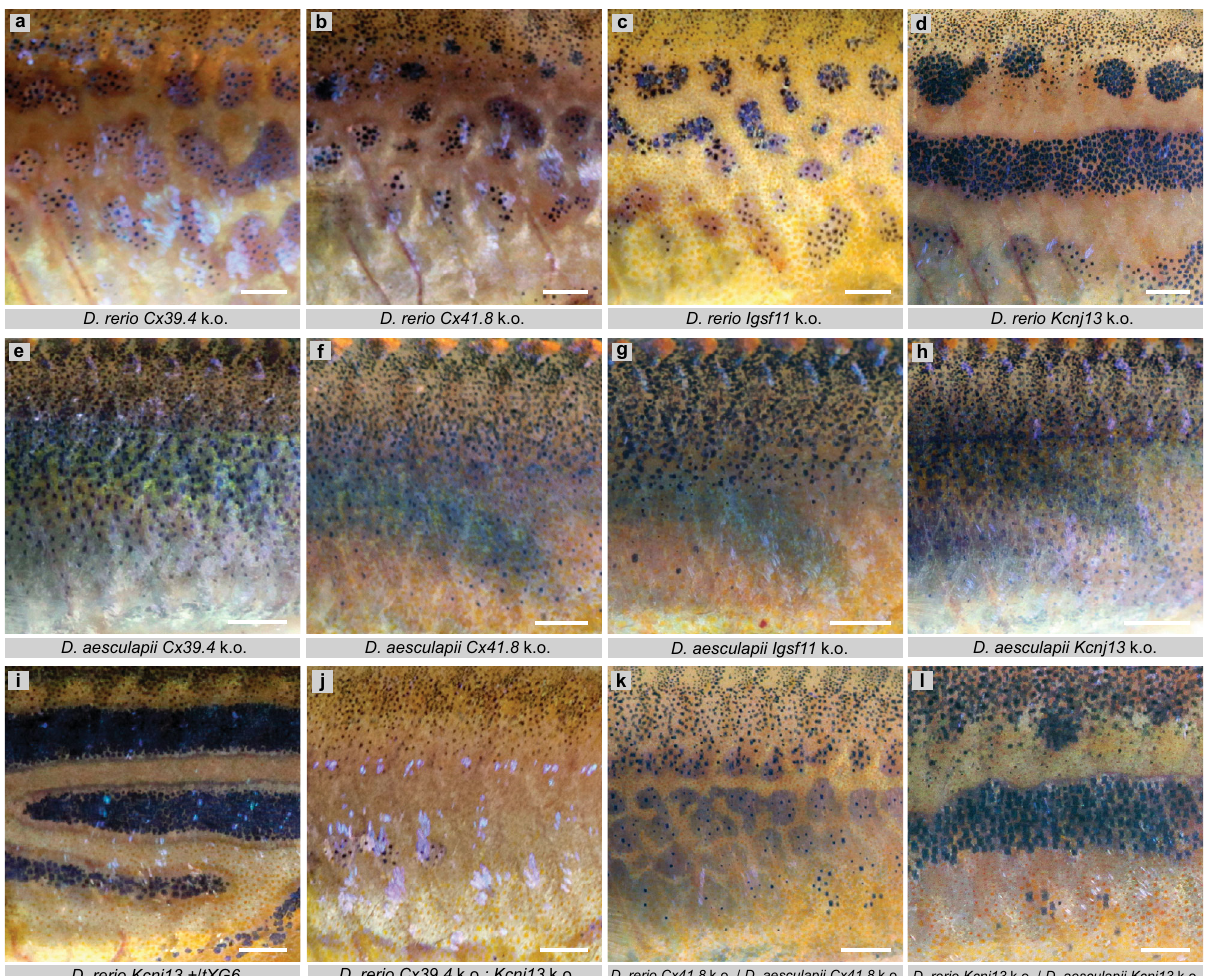
Fig. 4 Mutant phenotypes in D. rerio , D. aesculapii and their hybrids of genes required for heterotopic interactions. In D. rerio mutations in, a , Cx39.4 ( luchs ), b , Cx41.8 ( leopard ), and c , Igsf11 ( seurat ) lead to spotted patterns, whereas, d , mutations in Kcnj13 ( obelix ) result in fewer and wider stripes. In D. aesculapii , e – h , mutations in the orthologous genes lead to the complete loss of any pattern. In D. rerio dominant alleles of Kcnj13 , i , cause broader stripes and irregularities when heterozygous. Double mutants, j , Cx39.4 k.o.; Kcnj13 k.o., loose almost all melanophores and pattern. Interspeci fi c hybrids between D. rerio and D. aesculapii , which are both mutant, k , for Cx41.8 , or, l , for Kcnj13 , show patterns of spots or wider stripes similar to the corresponding D. rerio mutants ( b , d ; n = 15). All images show representative examples of the corresponding genotypes. Scale bars correspond to 1